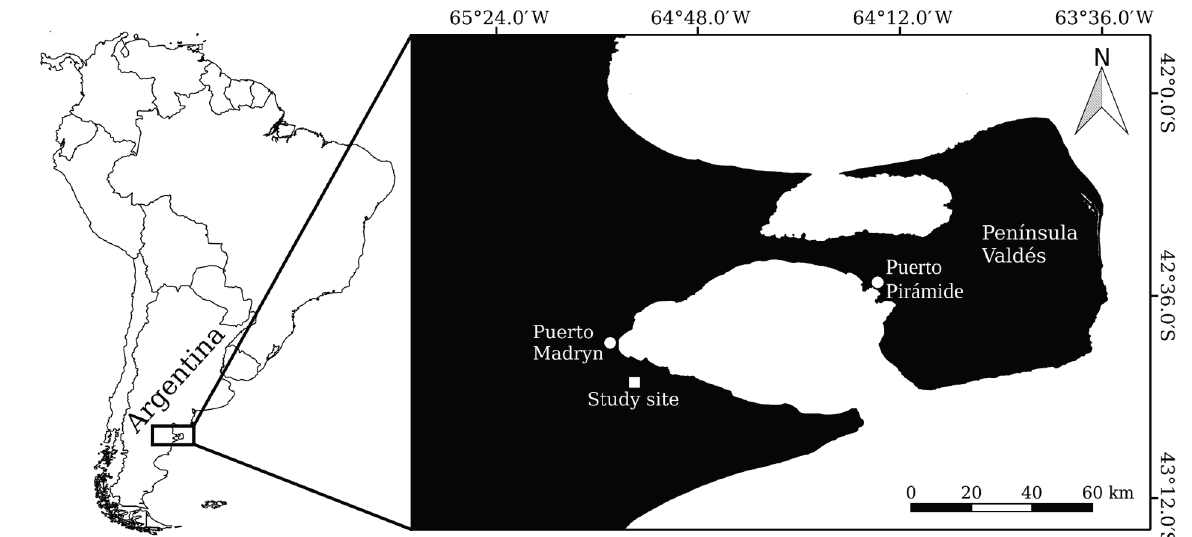
Figure 1. Location of the study site in the northeast of Patagonia,